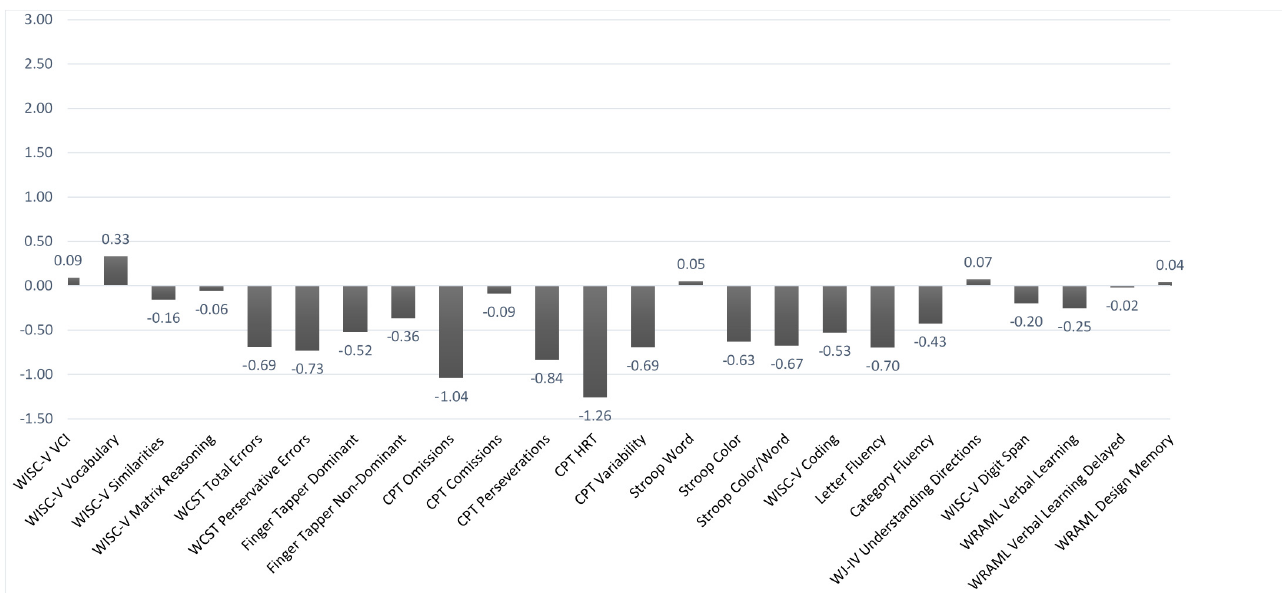
Figure 1. Performance Baseline Data. n = 17. The y-axis is based on z -scores (M = 0, SD = +/- 1). Lower scores indicate poorer performance. Weschler Intelligence Scale for Children-5 th ed. (WISC-V); Wisconsin Card Sorting Test (WCST); Conner’s Continuous Performance Test (CPT); Woodcock Johnson Test of Achievement-IV (WJ-IV); Wide Range Assessment of Memory and Learning (WRAML).